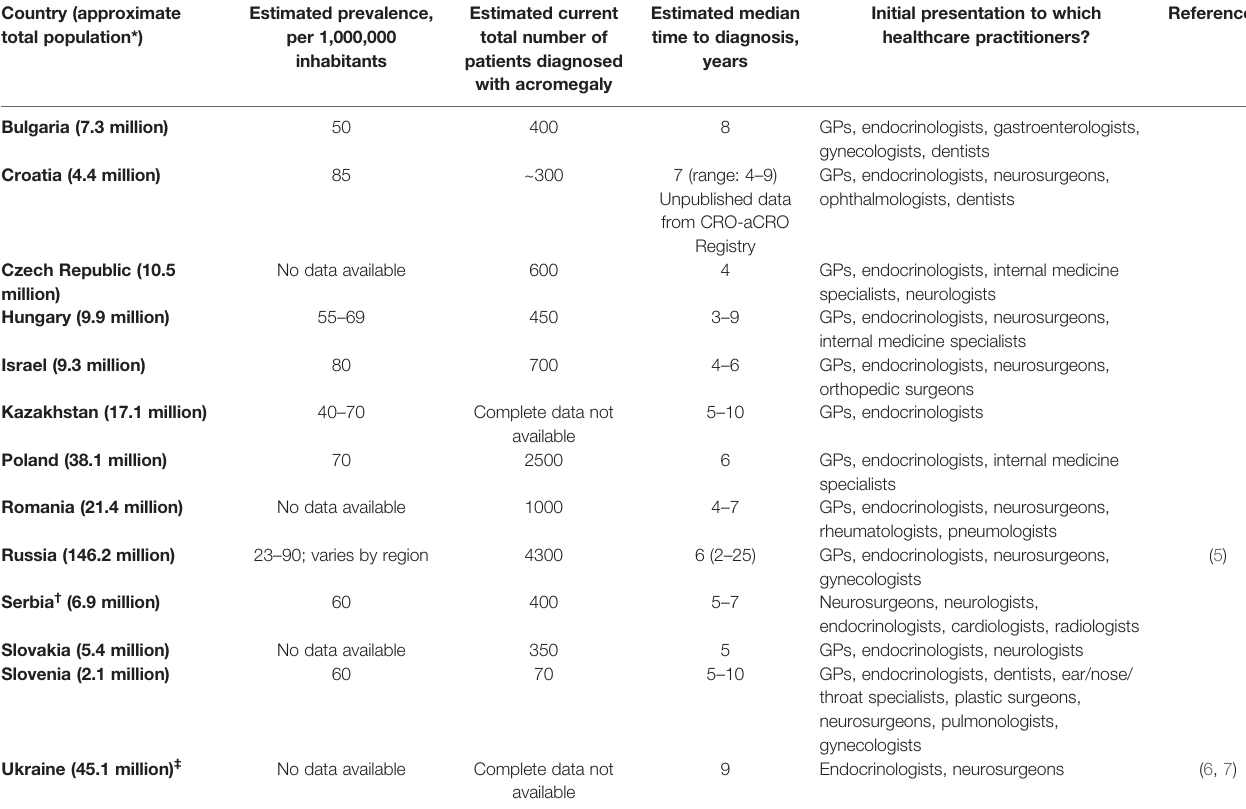
TABLE 1 | Estimated prevalence of acromegaly, the median time to diagnosis, and number of specialist centers, by country. Country (approximate total